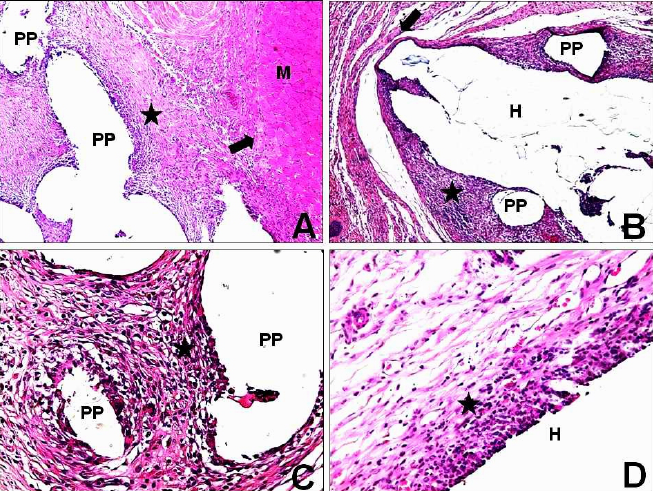
FIGURE 3 - Photomicrography of tissue response to polypropylene mesh implants and polypropylene -hydrogel 15 days after implantation (HE); ( A ) Evidentiating loose connective tissue around biomaterial, predominance of inflammatory infiltrated (star) and host tissue interface (arrow). Sample from group PP (50x); ( B ) Sample from group PH